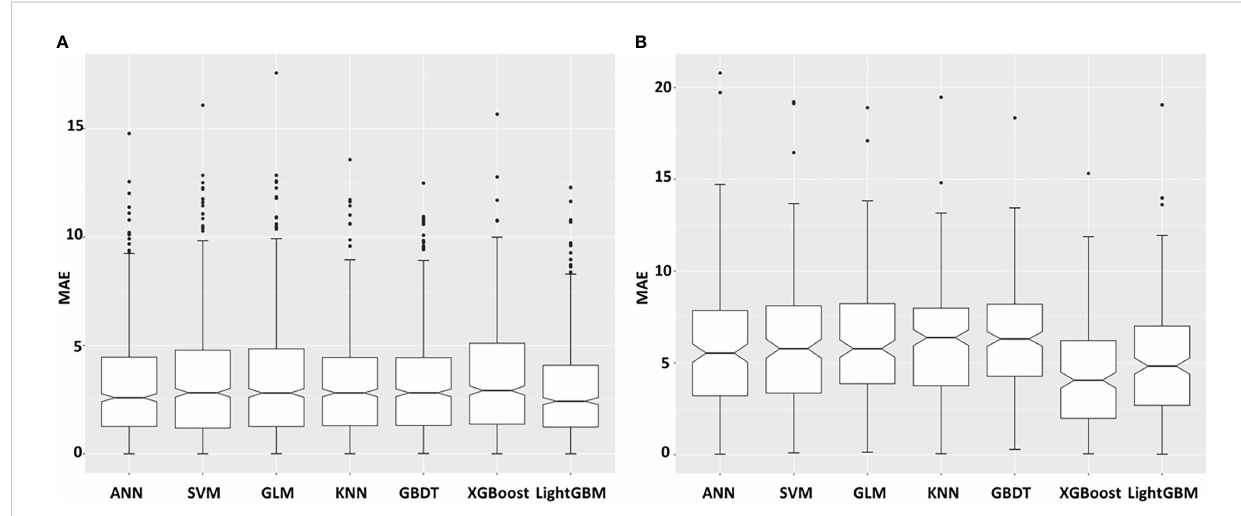
FIGURE 5 Mean absolute prediction errors (MAE) broken down for the seven different prediction models and different age groups: (A) 20 – 35 (B) >35 years.